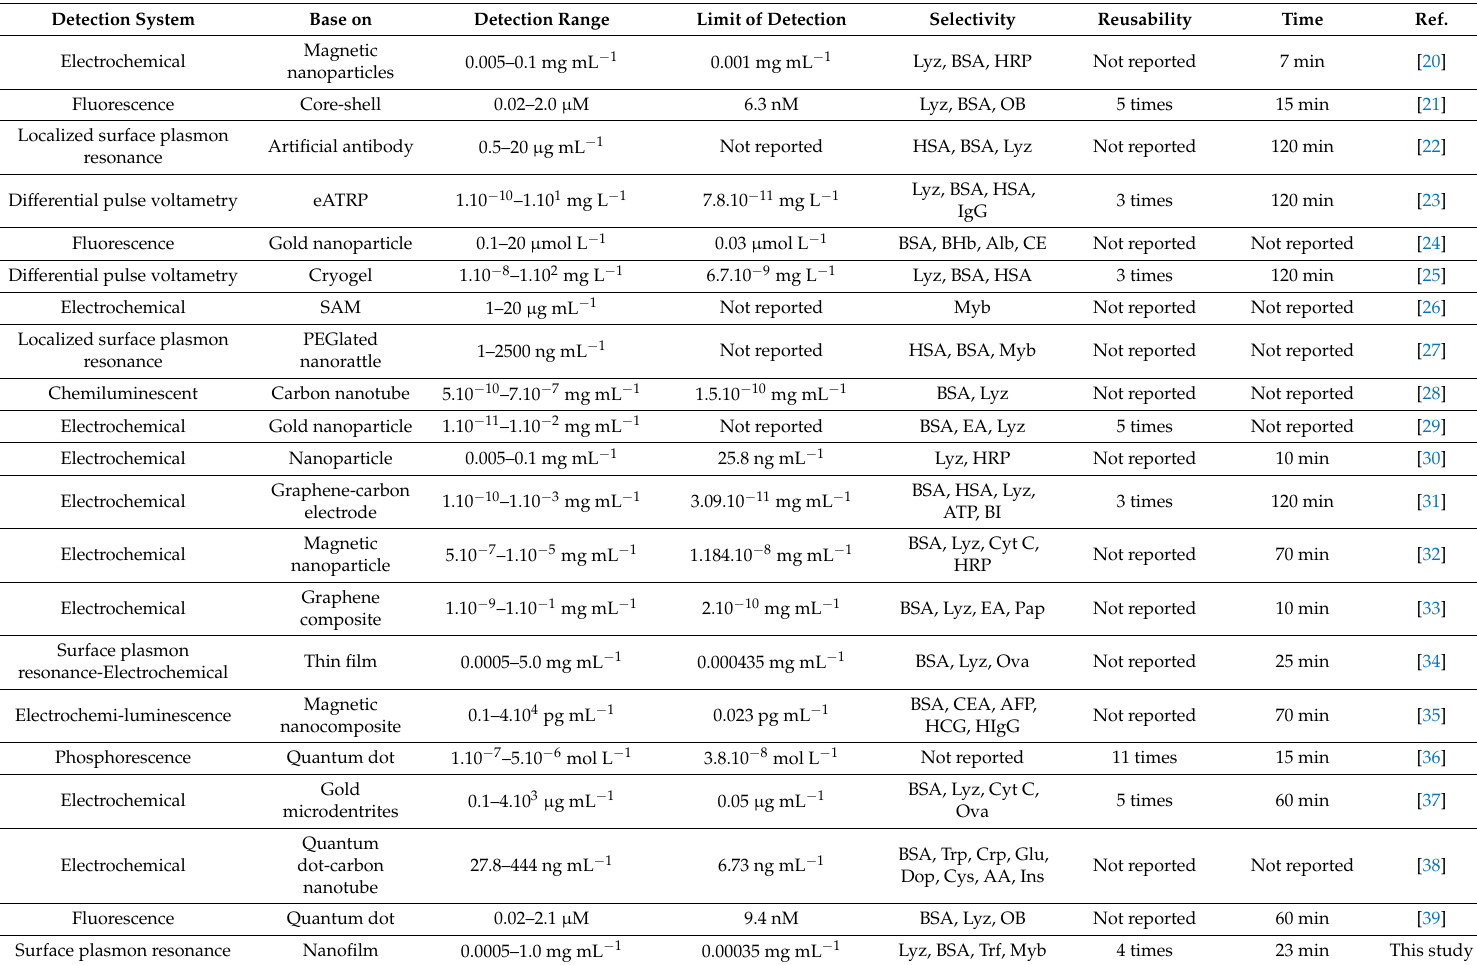
Table 3. The comparison of different detection systems with this study for hemoglobin